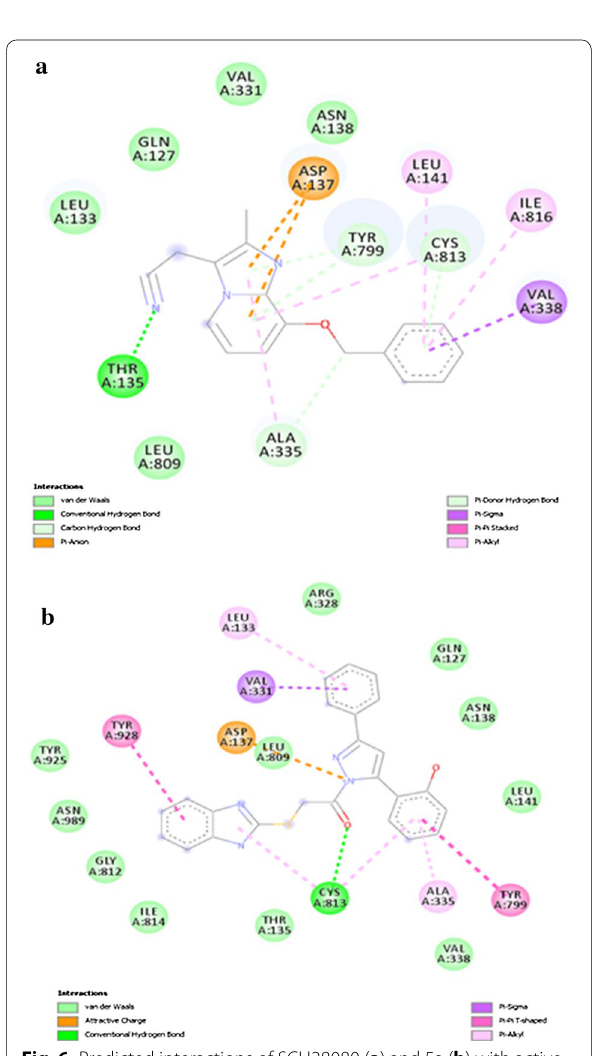
Fig. 6 Predicted interactions of SCH28080 ( a ) and 5a ( b ) with active site